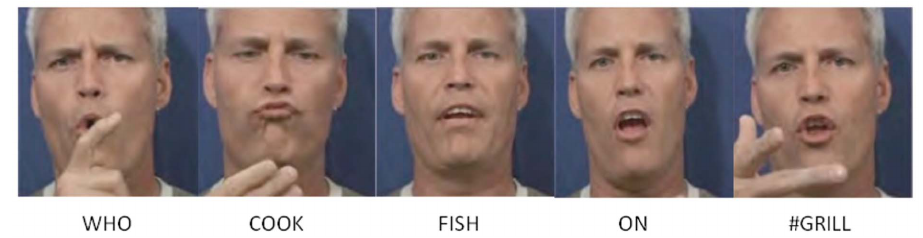
Figure 7. Mouth positions for the sentence ‘‘WHO COOK FISH ON # GRILL.’’